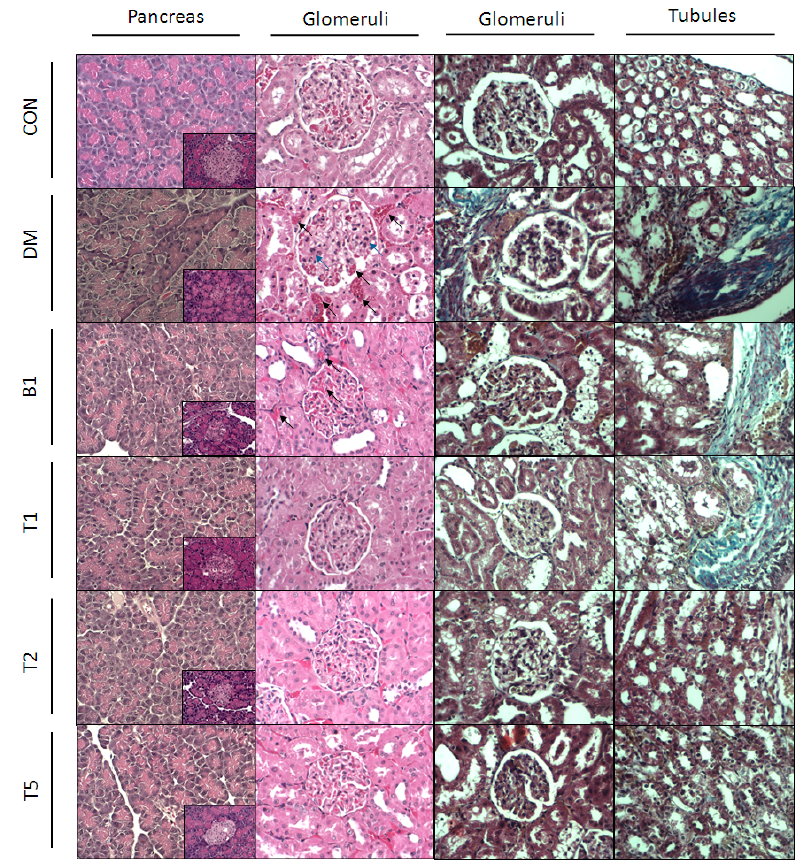
Figure 5. The typical graphs of H & E (left two panels) and Masson’s stains (right two panels) in the pancreas and kidney from six groups of rats.